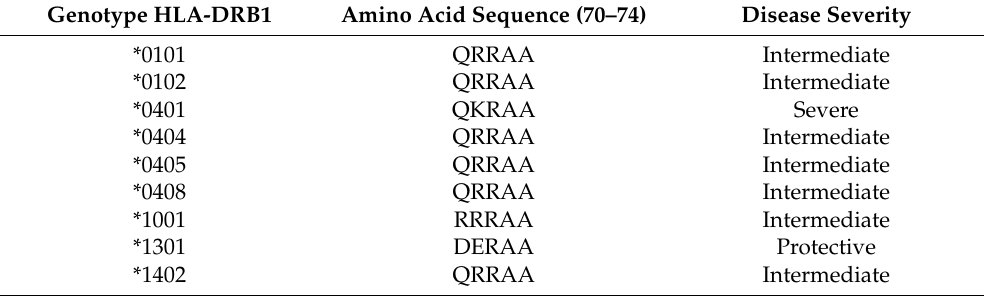
Table 1. Clinical significance of human leukocyte antigen HLA-DRB1 alleles in rheumatoid arthritis